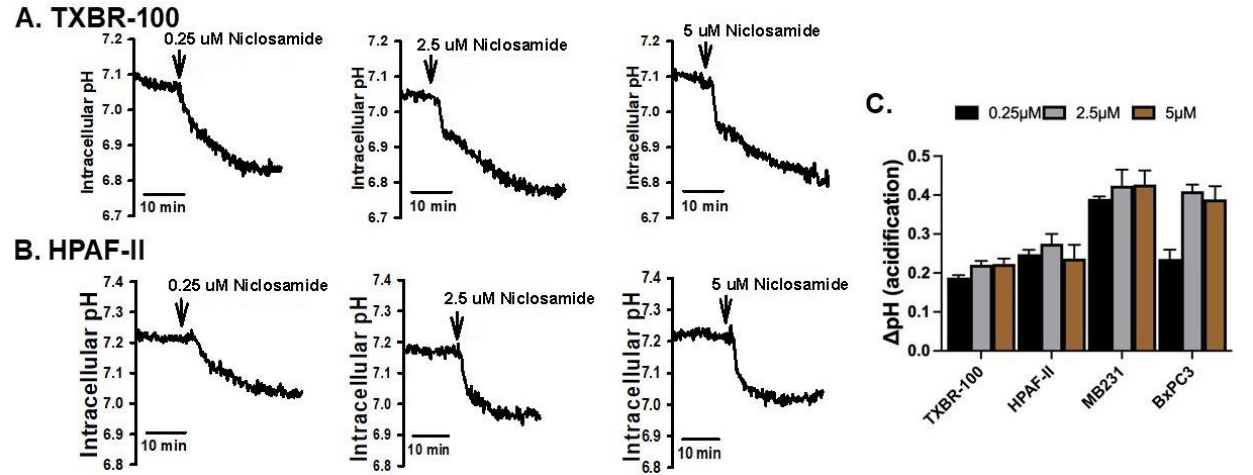
Figure 1. Intracellular acidification caused by niclosamide (three different concentrations) in TNBC cell line TXBR-100 ( A ) and pancreatic cancer cell line HPAF-II ( B ). The experiment was repeated in another TNBC cell line (MB231) and pancreatic cancer cell line (BxPC3). The magnitude of cellular acidification was quantified for each concentration of niclosamide; data (means ± S.E.M.) for all four cell lines are given ( C ) .